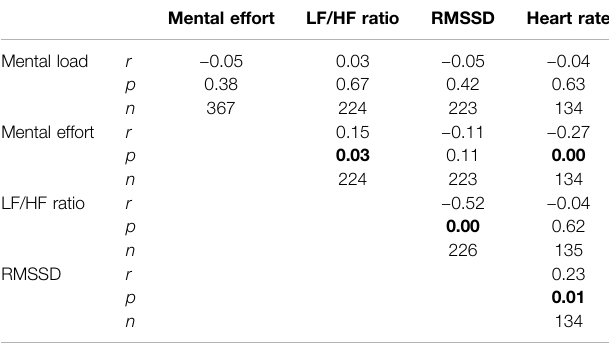
TABLE 3 | Pearson correlation coef fi cients r between objective and subjective measures of cognitive load for the total sample. Mental